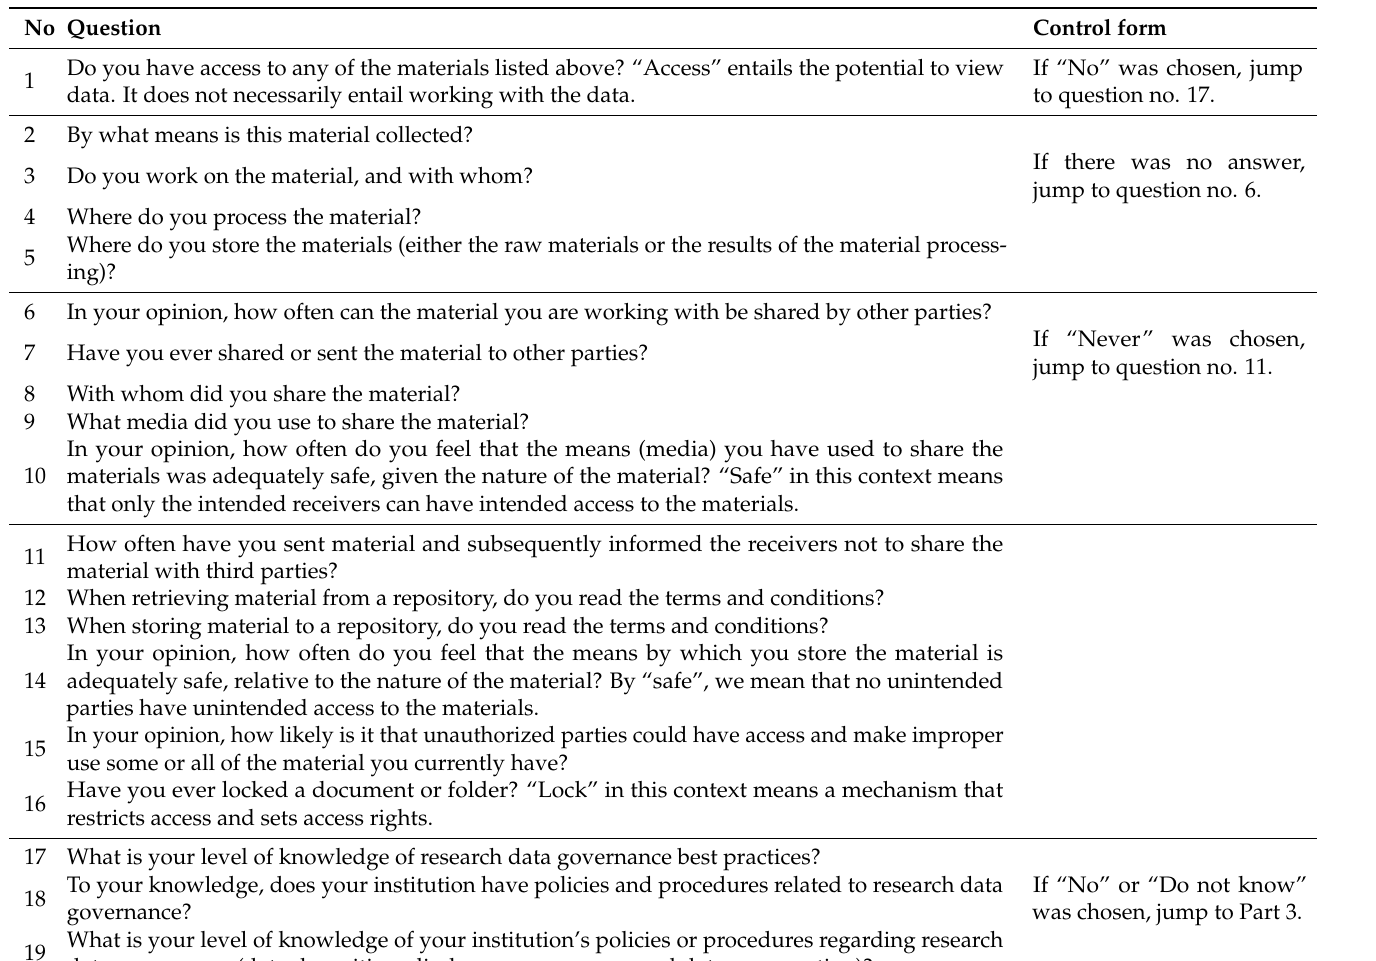
Table A2. Questionnaire: part